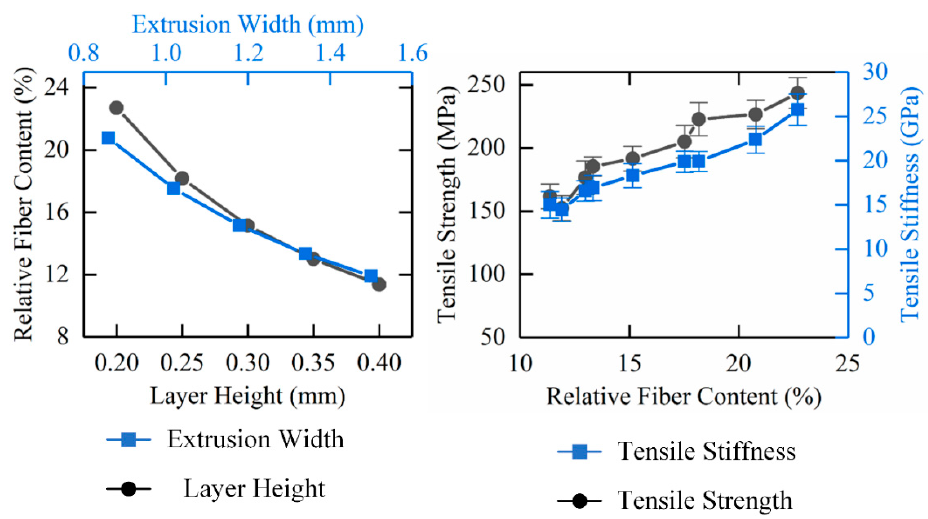
Figure 12. Effect of relative fiber content on tensile mechanical properties of continuous carbon fiber-reinforced 3D printing.